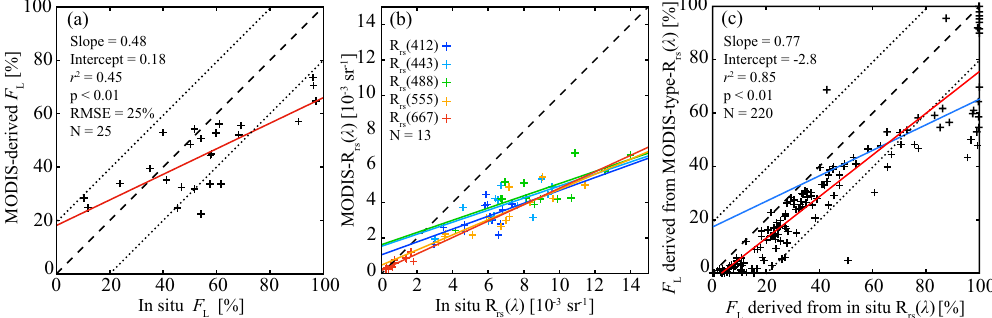
Figure 2. Scatter plots of (a) satellite-derived F L vs. in situ observed surface F L ( r 2 = 0.45, p <0.01, N = 25, RMSE = 25%), (b) satellite- derived R rs (λ) vs. in situ-measured R rs (λ) ( N = 13, slopes and intercepts for each λ are listed in Table 2), and (c) F L derived from MODIS- converted R rs (λ) vs. F L derived from in situ R rs (λ) ( r 2 = 0.85, p <0.01, N = 220). Dashed lines are 1 : 1 lines, dotted lines indicate ± 20% from 1 : 1 (Fig. 2a and c), and coloured solid lines represent the regression line, respectively. The regression line of Fig. 2a is also shown in Fig. 2c with the blue solid line for